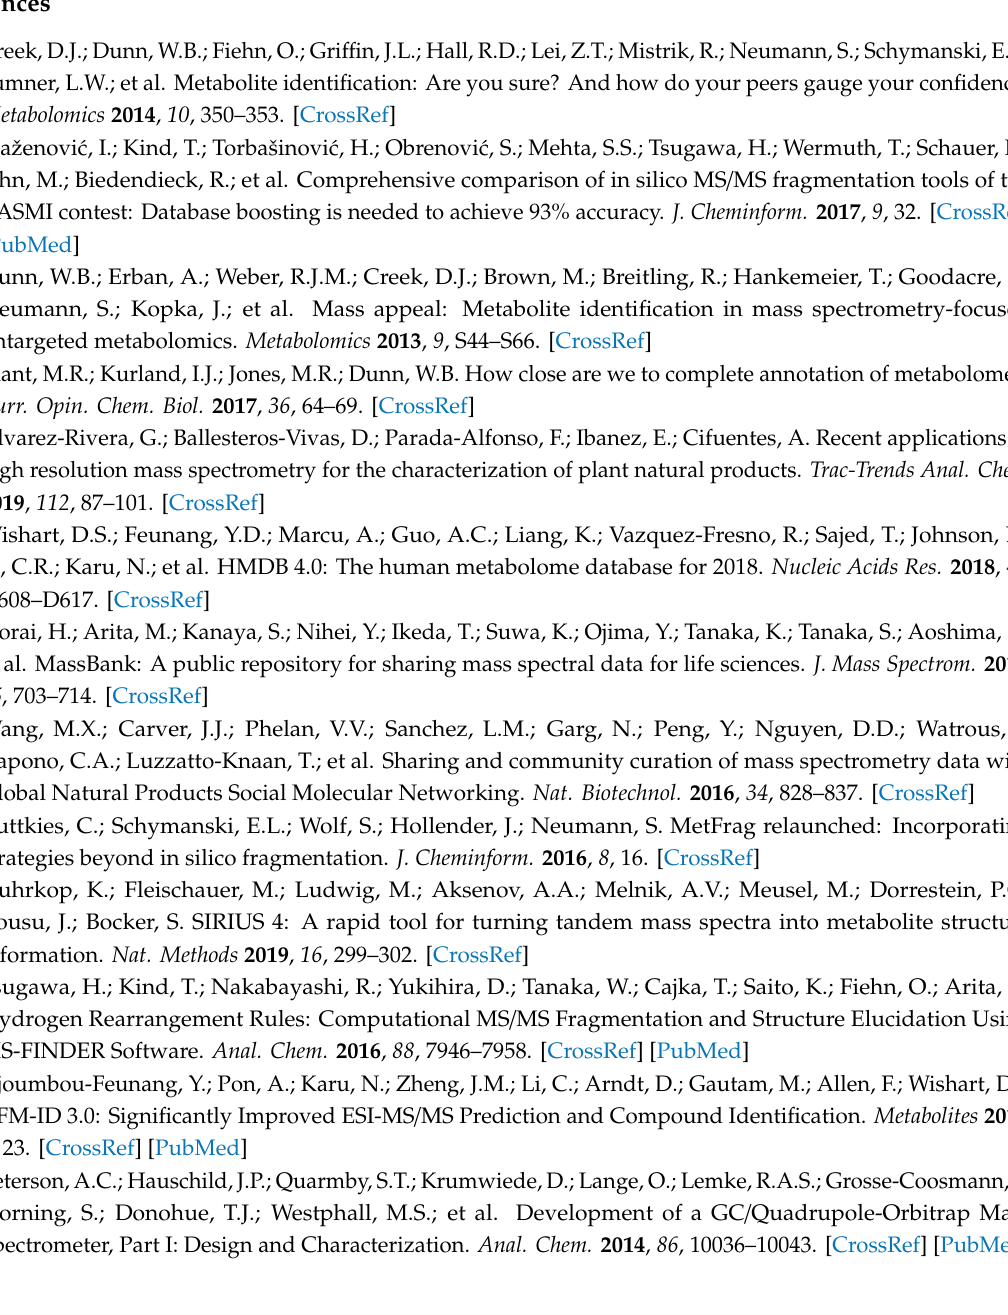
Figure S1: E ff ect of data curation steps of feature / compound number, Figure S2: Comparison of matching scores between ISQ and Orbitrap, Figure S3: Comparison of analytical variability between ISQ and Orbitrap, and Table S1: Evaluation of reproducibility of peak areas on both